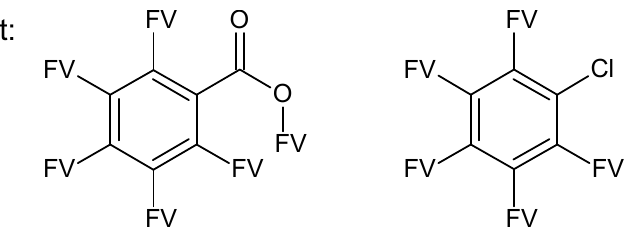
Figure A6. Substructures for GC–MS Challenge 7. FV = free